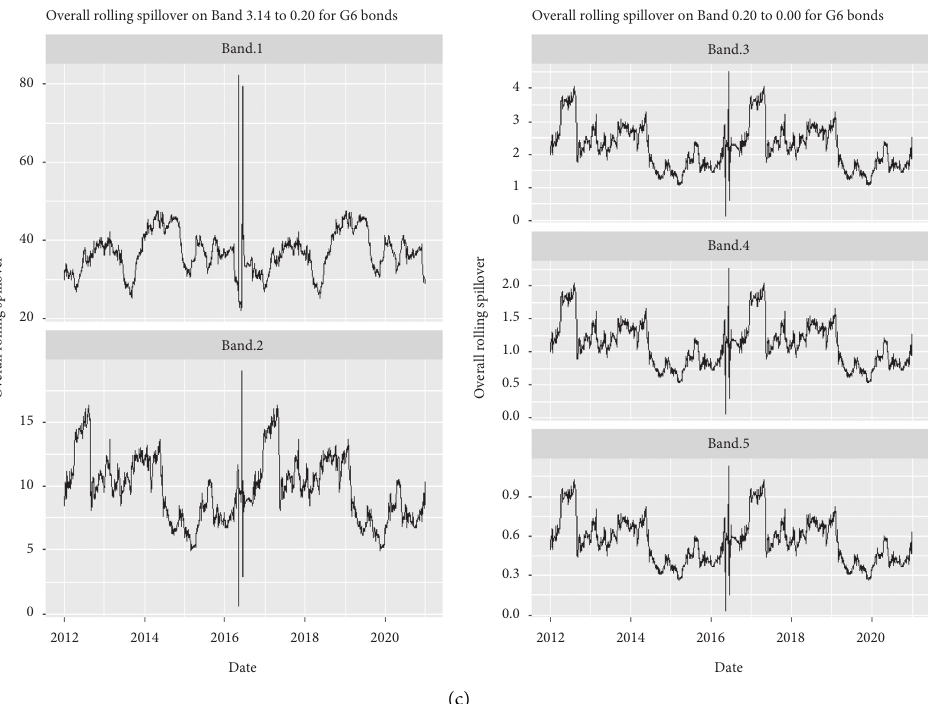
Figure 2: Overall rolling spillovers across time horizons. (a) Panel A: Islamic and G6 bond markets. (b) Panel B: Islamic bond markets. (c) Panel C: G6 bond